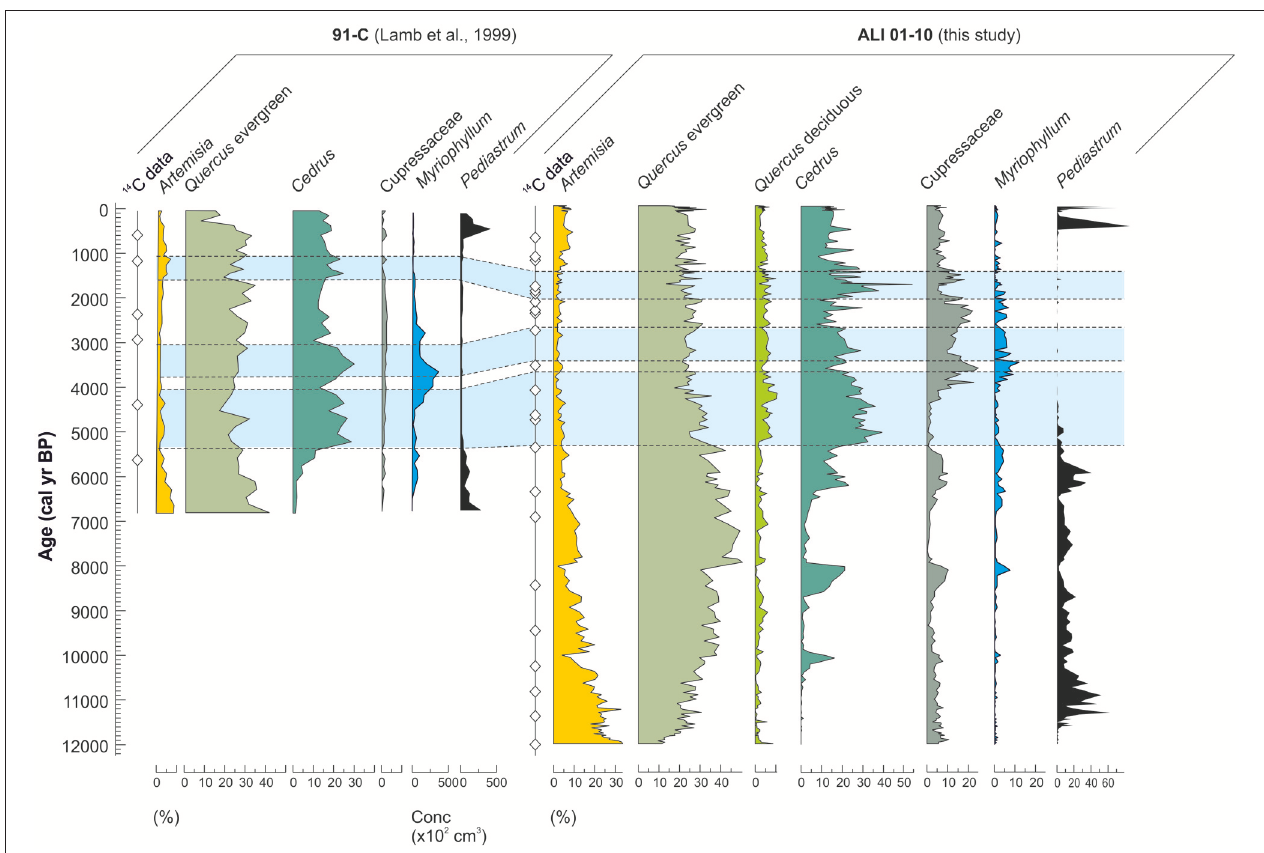
FIGURE 8 | Comparison of the pollen records from Lake Sidi Ali cores 91-C (Lamb et al., 1999) and ALI 01-10 (this study), showing select pollen taxa and radiocarbon chronological